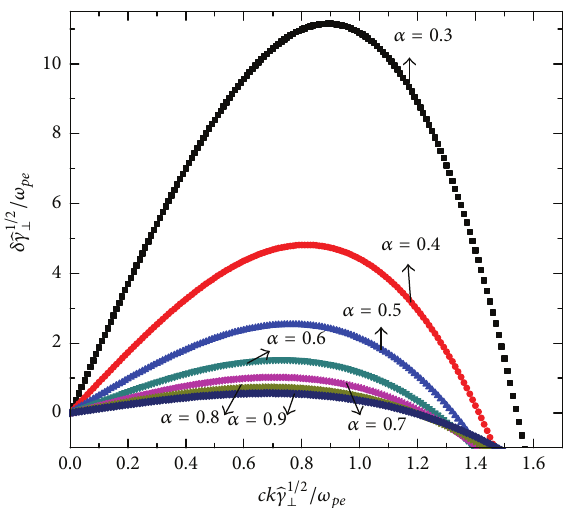
Figure 4: Variation of the normalized growth rate, (𝛿/𝜔 𝑝𝑒 )̂𝛾 1/2 ⊥ , according to (𝑐𝑘/𝜔 𝑝𝑒 )̂𝛾 1/2 ⊥ for difference 𝛼 in limits 𝜂 = 0.909 and ̂𝛾